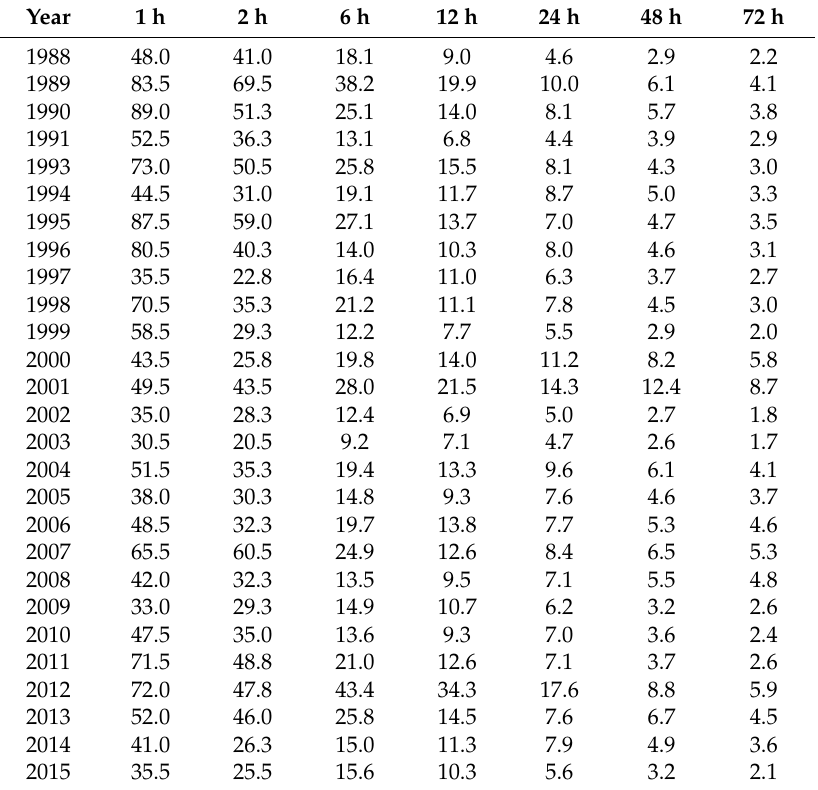
Table 1. Annual maximum rainfall intensities (mm/h) at Zhongli Station, Taiwan.